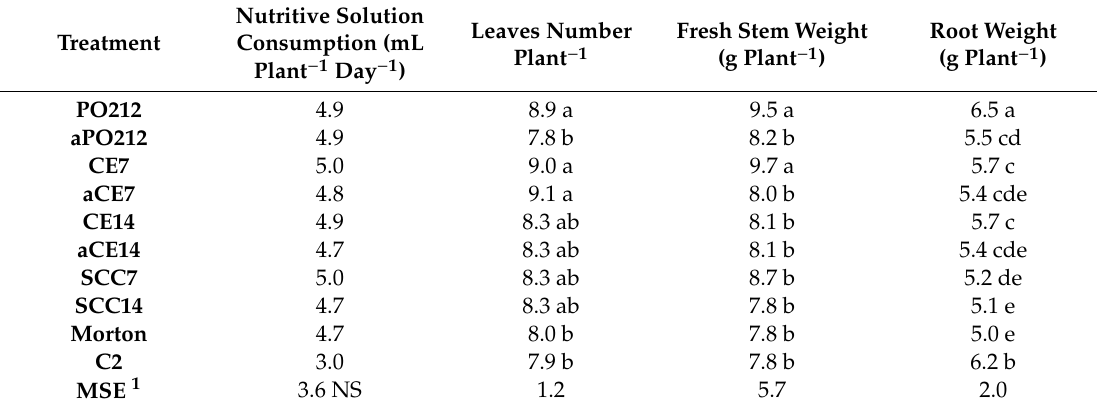
Table 3. E ff ect of Penicillium rubens strain 212 (PO212) crude extracts (CE) and conidia (SCC) on the growth of tomato plants non- inoculated with strain 1A of Fusarium oxysporum f.sp. lycopersici (FOL1A) at 28 days after transplanting in growth chamber conditions